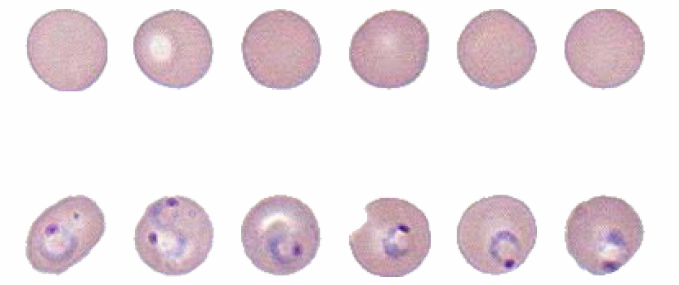
Figure 1. Cropped red blood-cell samples. Top row shows non-infected cells, bottom row shows infected cells. The purple nucleus and blue ring make the malaria